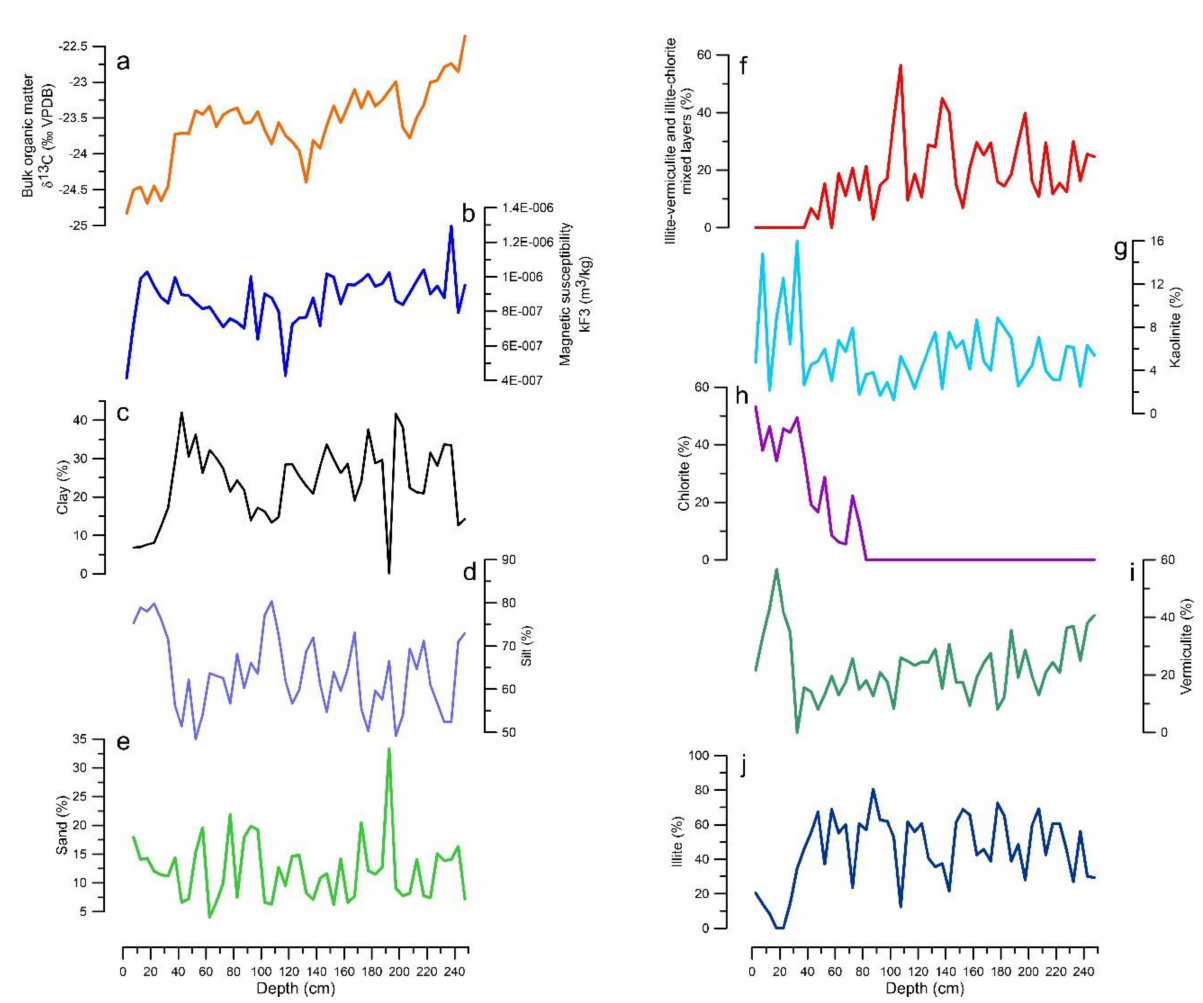
Figure 5. Variation of bulk organic matter δ 13 C ( a ), magnetic susceptibility ( b ), grain size ( c – e ), and clay mineralogy ( f – j ) with